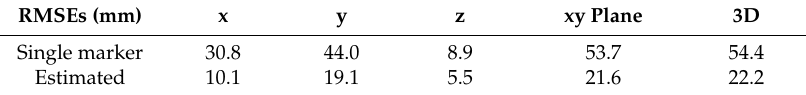
Table 1. Root mean square errors (RMSEs) of hovering flight at 1 m in di ff erent cases. RMSEs (mm)